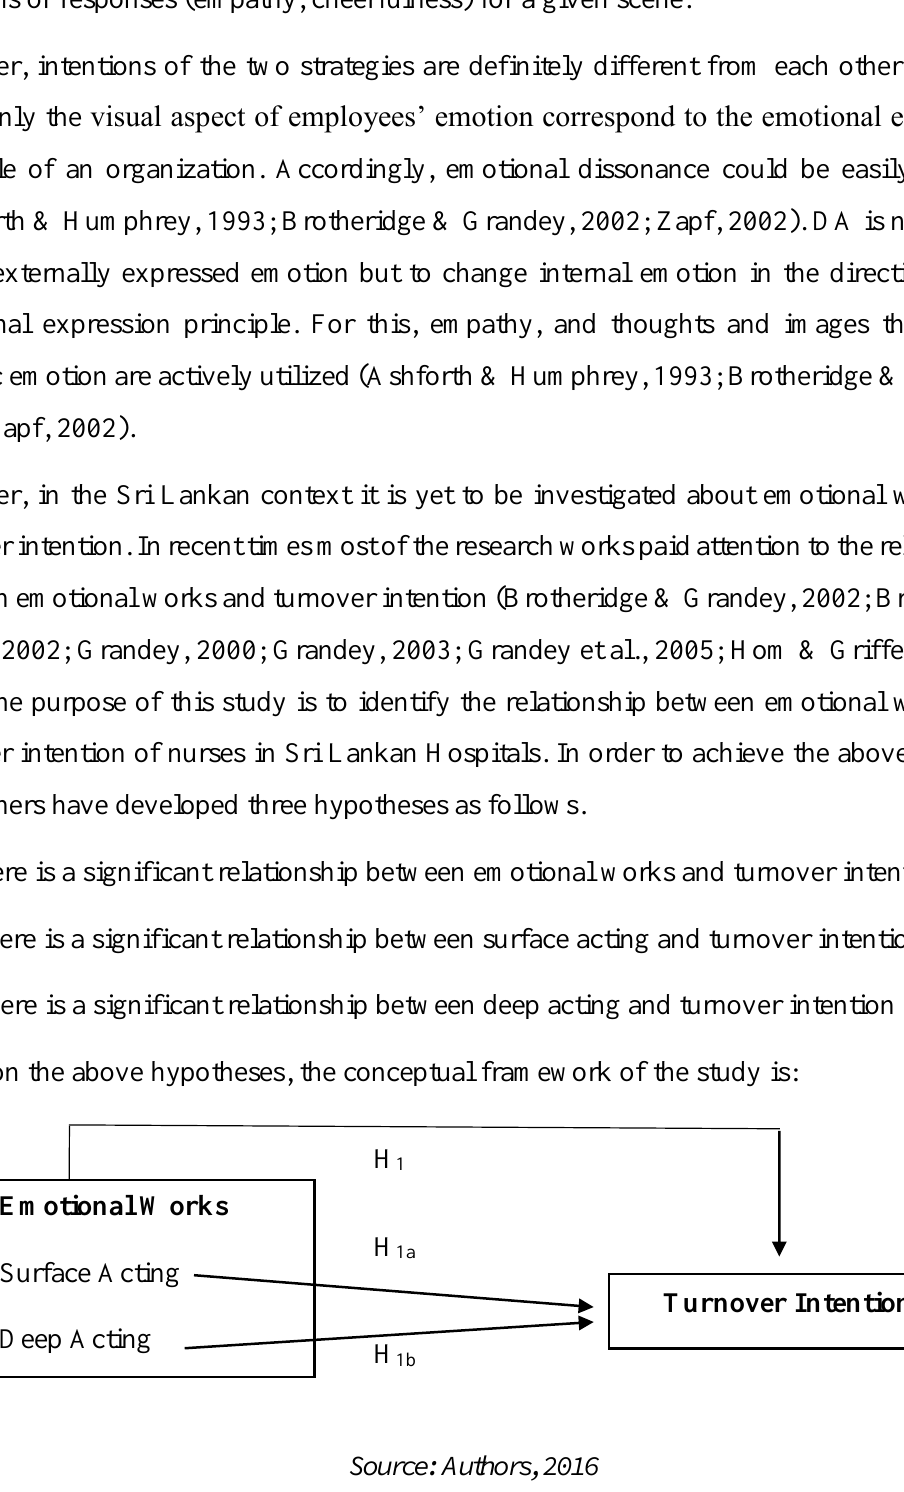
Fig 1: Relationships between Emotional Works and Turnover